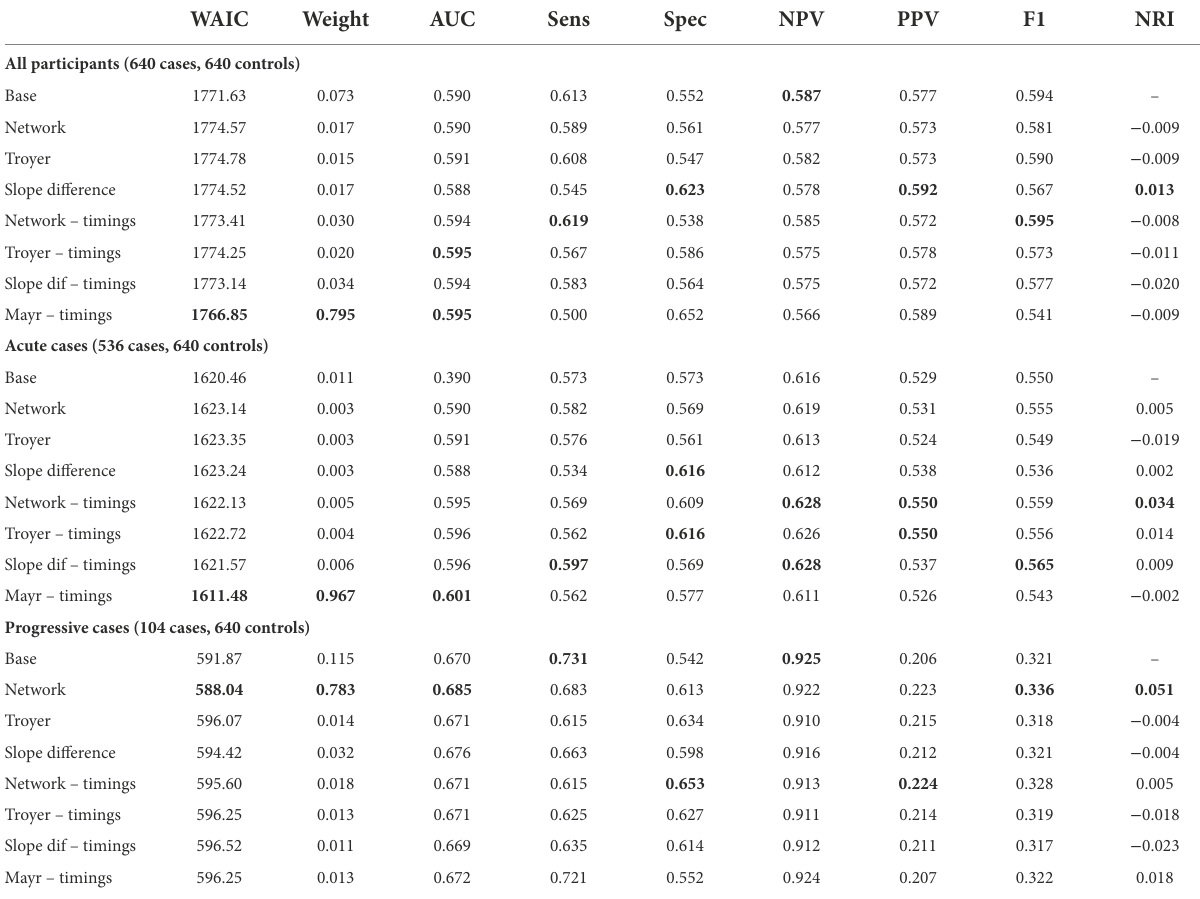
TABLE 4 Performance of models fit with letter F fluency data.